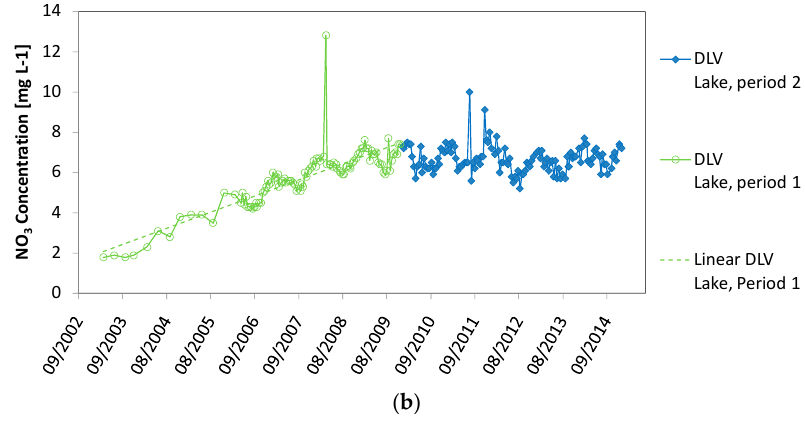
Figure 8. ( a ) NO 3 concentration of gravel pit lake with artificial recharge (DLV Lake), groundwater fed only (BP Lake) and Meuse River from 2002 to 2016; ( b ) NO 3 concentration of gravel pit lake with artificial recharge (DLV Lake) and linear regression trend line over the period 2002–2009 and 2010–2014.